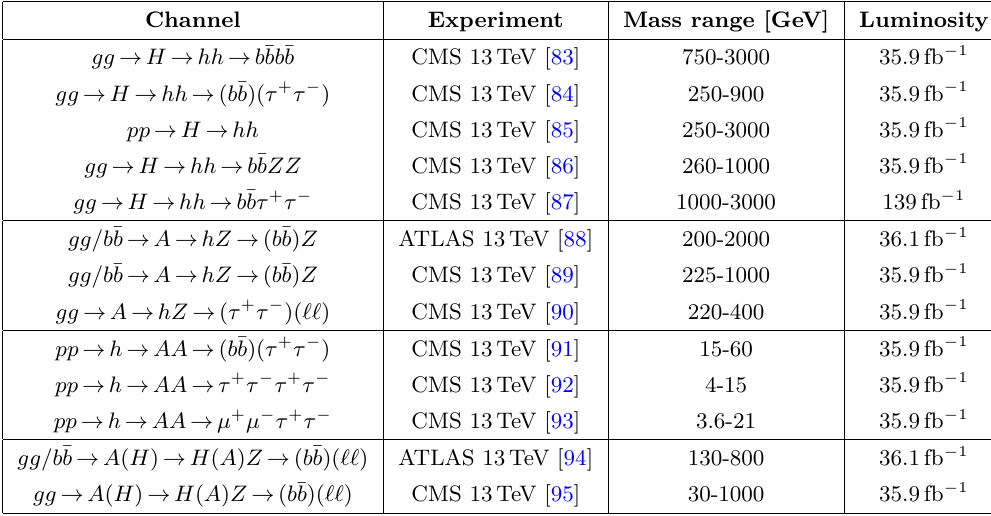
Table 2 . The upper limits at 95% C.L. on the production cross-section times branching ratio for the channels of Higgs-pair and a Higgs production in association with Z at the